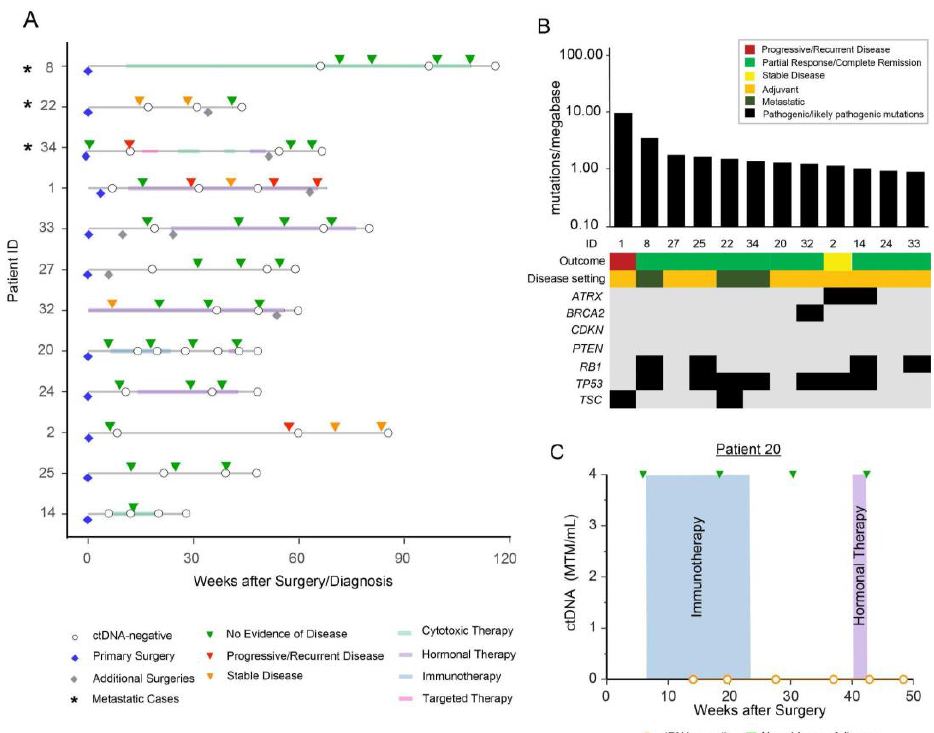
Figure 1. ( A ) Overview plot depicting the complete clinical course of all patients within sub-cohort A (patients who tested negative for ctDNA at all time points), including results of longitudinal ctDNA analysis. Patients with metastatic disease are marked with an asterisk “*” symbol. Blue diamond reflects initial/primary surgery performed to build the personalized ctDNA assay, all other additional surgeries are represented with grey diamonds. ( B ) Distribution of pathogenic and likely pathogenic driver mutations across all 12 patients in sub-cohort A. ( C ) Clinical course for patient #20 depicting immunotherapy and hormonal therapy, with radiologic surveillance and ctDNA levels over time. The debulking procedure prior to the initiation of immunotherapy was used to build a personalized ctDNA assay.